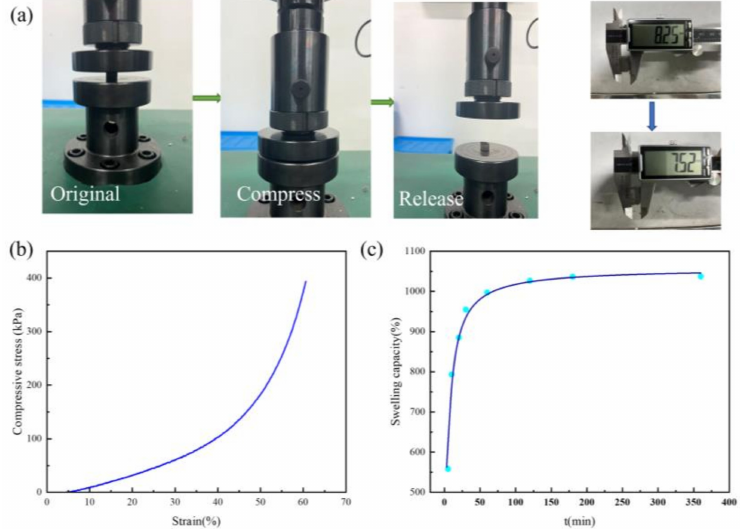
Figure 5. ( a ) GO − ATP@CS − PVA compression and release of aerogel; ( b ) Stress–strain curve of GO − ATP@CS − PVA; ( c ) Aerogel swelling performance